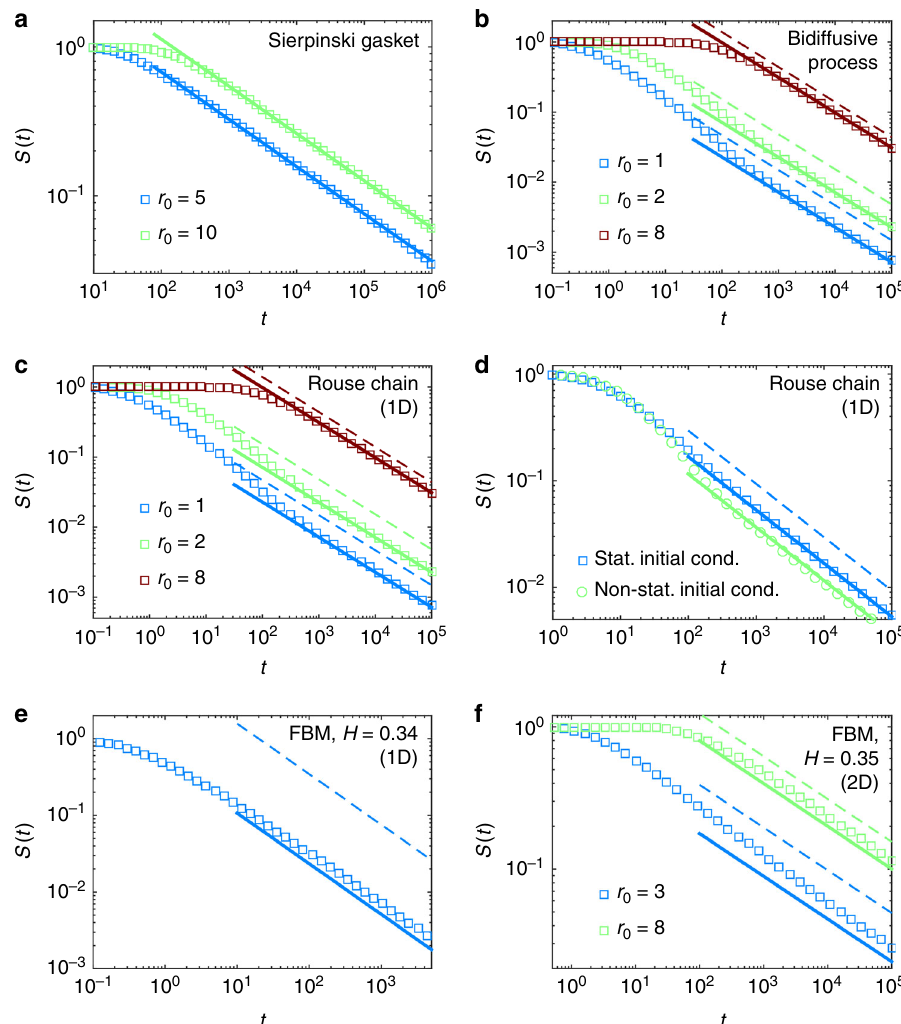
Fig. 2 Survival probability S ð t Þ for various stochastic processes. In all graphs, symbols are the results of stochastic simulations (detailed in SI), continuous lines give the theoretical predictions (Eq. (18)), and dashed line represent the predictions of the pseudo-Markovian approximation (The pseudo-Markovian approximation, which is similar to the Wilemski – Fixman approximation for the polymer cyclization kinetics problem, consists in using effective propagators in Eq. (18), i.e p ð x ; t j x 0 Þ ¼ e (cid:3)ð x (cid:3) x 0 Þ 2 = 2 ψ ð t Þ = ð 2 πψ ð t ÞÞ d = 2 .). a S ð t Þ for a random walk on the Sierpinski gasket for two values of the initial (chemical) source- target distance. Here, d f ¼ ln3 = ln2 , d w ¼ ln5 = ln2 , and K ’ 0 : 30 31 . Simulations are shown for a fractal of generation 11. Continuous lines are the